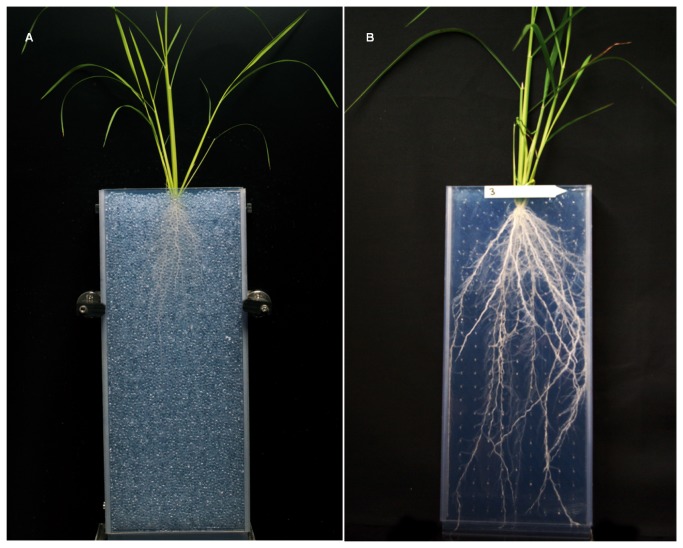
Rhizoboxes used in the Rhizoscope phenotyping platform.a. With beads. b. After bead removal.